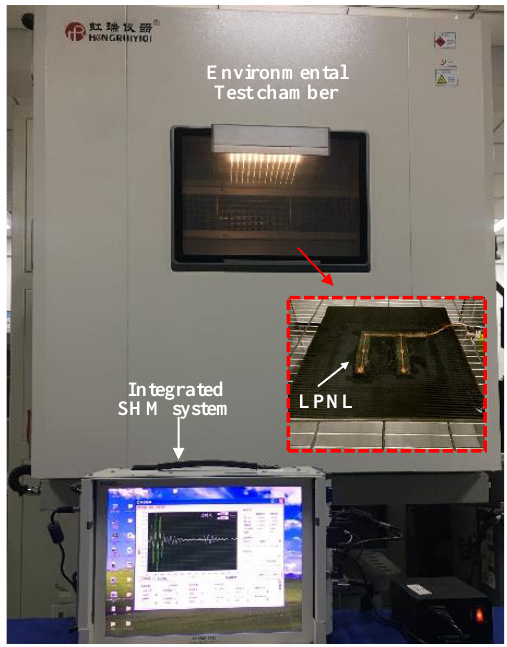
Figure 4. Experimental setup of temperature test.